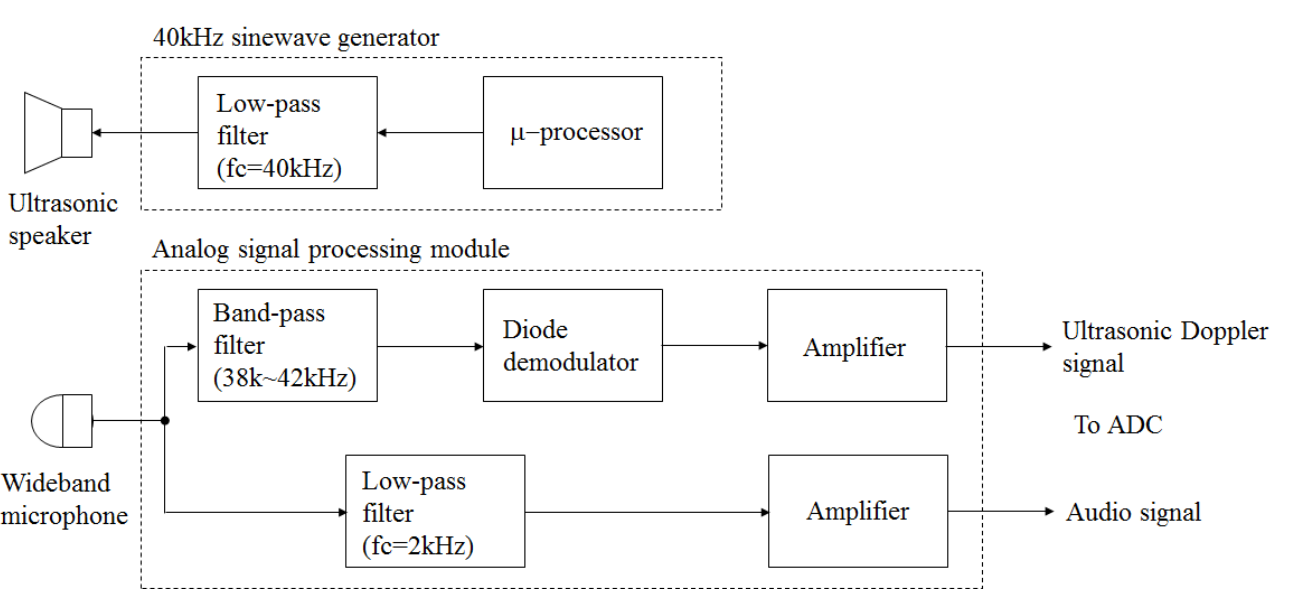
Figure 2. Block diagram of the developed sensor